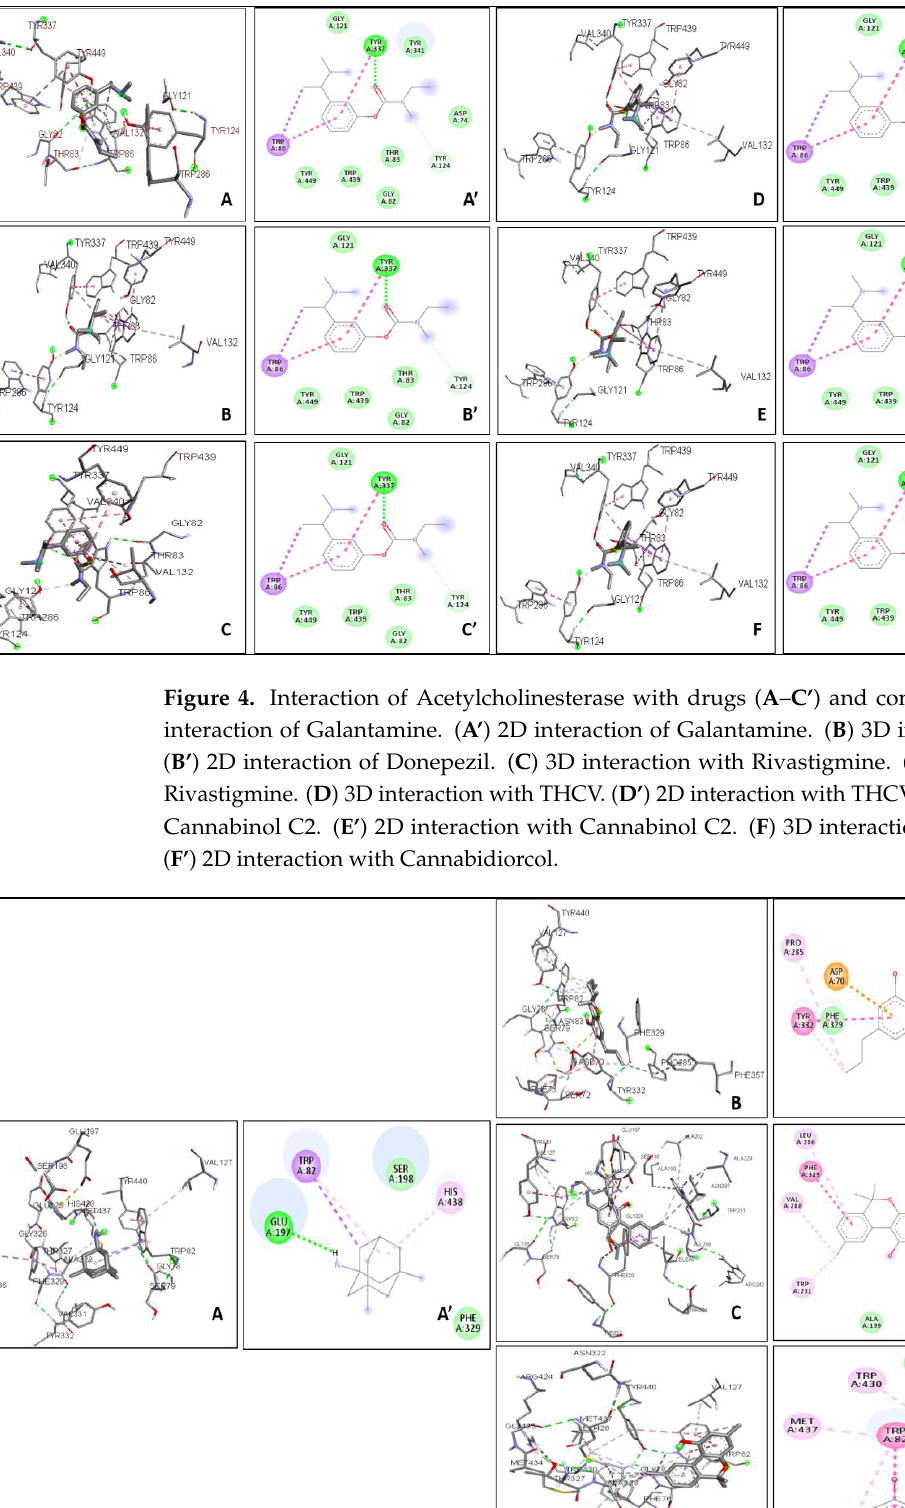
Figure 3. Graphical representation showing comparison of binding affinity and inhibition constant among ( A , C ) AChE inhibitors (Donepezil, Rivastigimine, Galantamine) and THCV, Cannabinol C2 and Cannabidiorcol ( B , D ) Butyrylcholinesterase inhibitors (Memantine) and THCV, Cannabinol C2 and Cannabidiorcol (* p < 0.1, ** p < 0.01, *** p < 0.001) and values are mean ± standard deviation